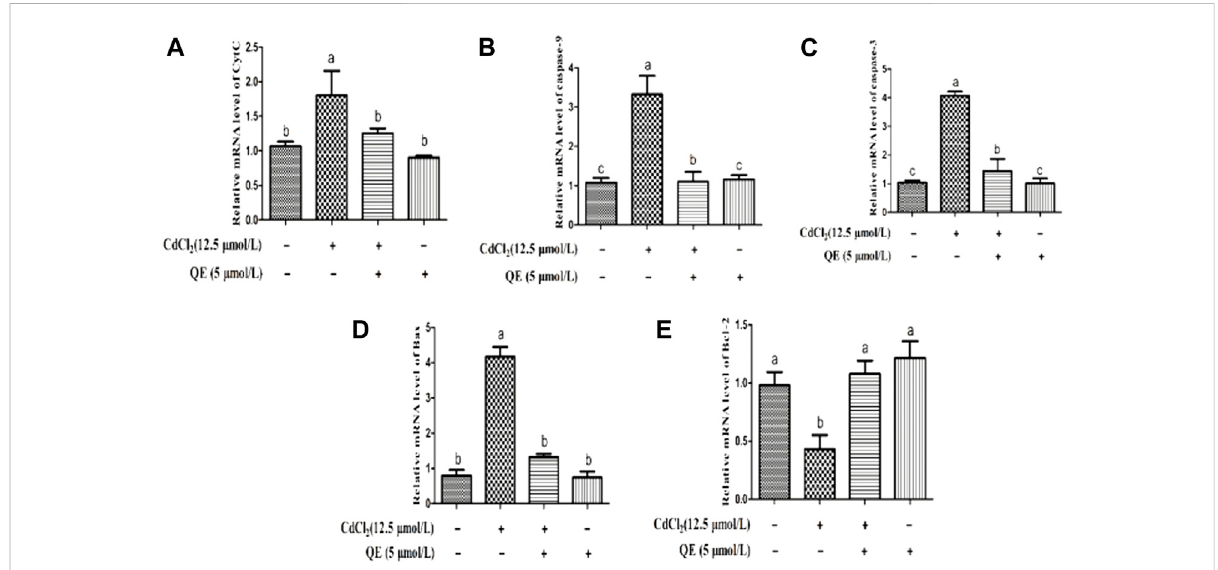
FIGURE 8 Effects of QE on Cd-induced BRL-3A cell apoptosis-related gene mRNA expression. The relative mRNA level of CytC (A) , caspase-9 (B) , caspase-3 (C) , Bax (D) and Bcl-2 (E) in BRL-3A cells. The data are expressed in the form of mean ± SEM, and data with different letters (a, b, and c) represent signi fi cantly different ( p < 0.05) among different